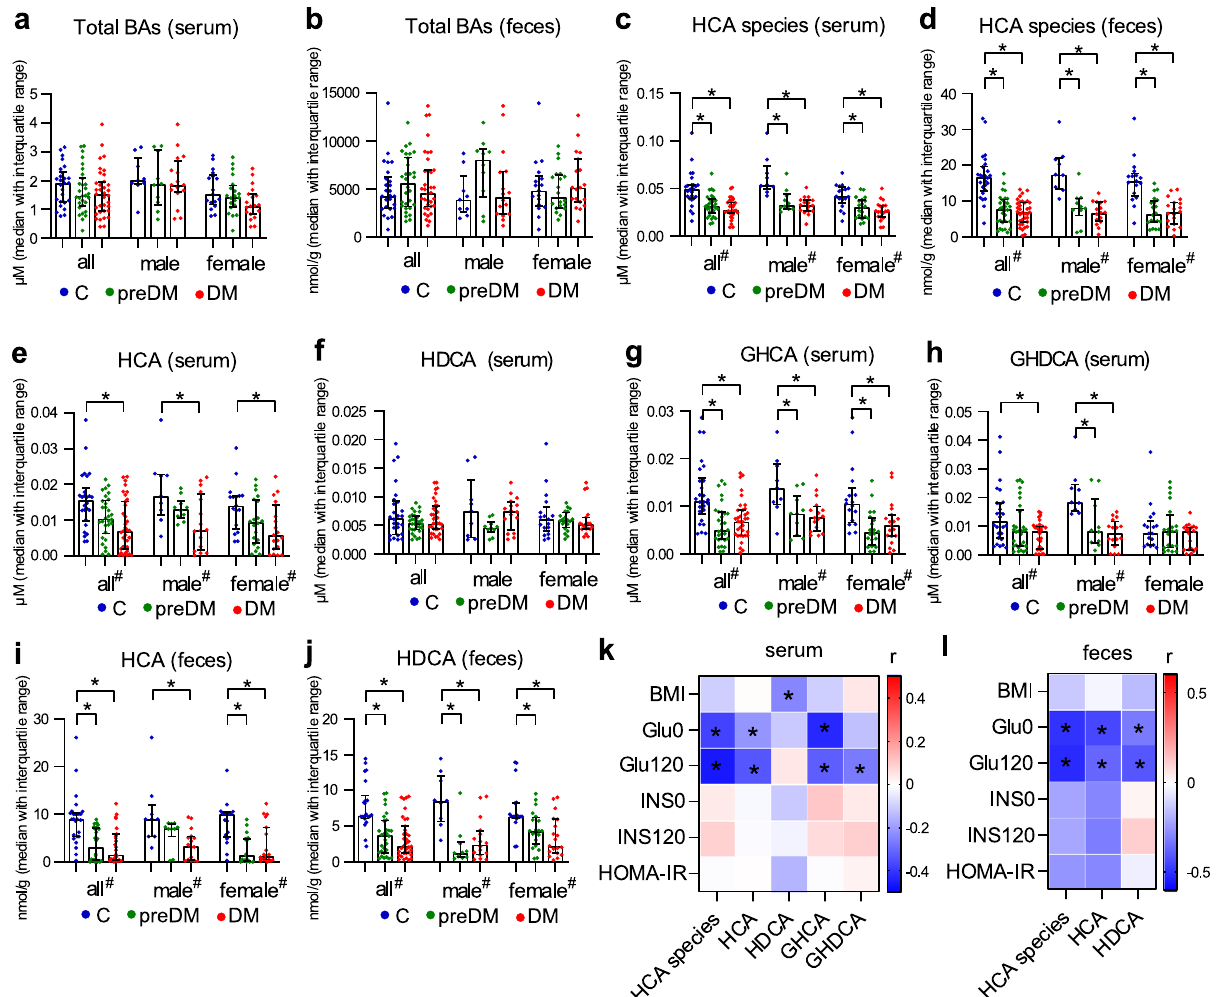
Fig. 2 Performance of HCA species in the second cross-sectional study. a – d Total BAs and total HCA species in serum and feces of healthy control (C, n = 26), pre-diabetes (preDM, n = 30) and diabetes (DM, n = 35) groups. e – j Individual HCA species in the three groups in all ( n = 91), male ( n = 35) and female ( n = 56) samples. k , l Heatmaps of Spearman correlation coef fi cients of total and individual HCA species in serum and feces with representative metabolic markers. Data are expressed as median with interquartile range ( a – j ). In the bar plots ( a – j ), * and # indicate the statistical signi fi cance ( p < 0.05) between two groups and among three groups, respectively, based on two-sided Kruskal – Wallis test. In the heatmaps ( k , l ), r value indicates Spearman correlation coef fi cient, and * indicates the statistical signi fi cance ( p < 0.05) based on Spearman correlation. HCA species in serum is the concentration summation of HCA, HDCA, GHCA, and GHDCA. HCA species in feces is the concentration summation of HCA and